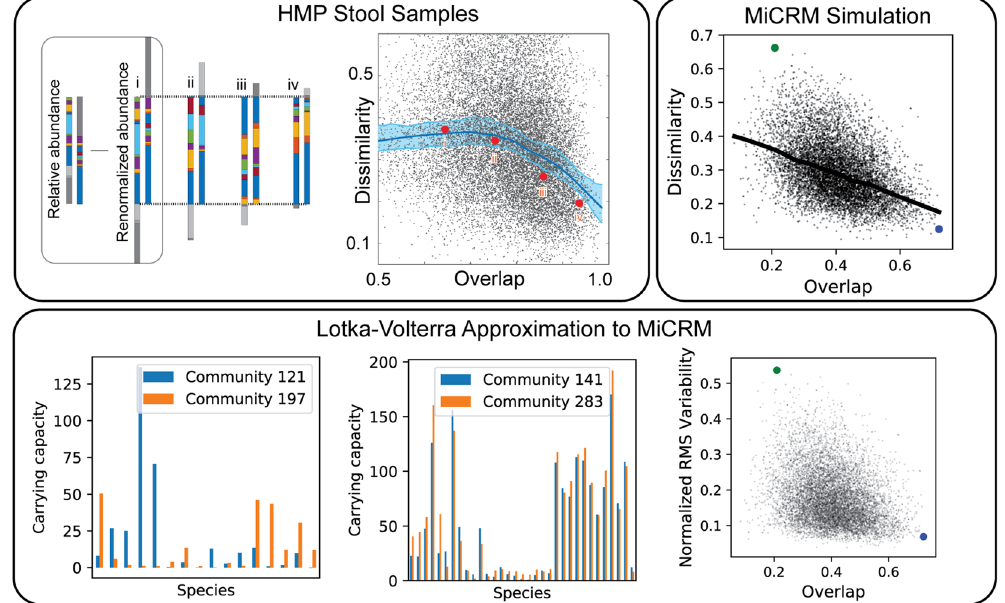
Figure 9. Host-specific dynamics are compatible with dissimilarity-overlap correlation. Top left: The composition of pairs of samples can be compared in two independent ways: “overlap” measures the fraction of each sample comprised by species common to both, and “dissimilarity” measures how different the relative abundance profiles are within this shared pool. The four pairs shown here have increasing overlap and decreasing dissimilarity from left to right, corresponding to the four points indicated in the scatter plot. Dissimilarity and overlap are plotted for 17,955 pairs of stool samples from the HMP, analyzed at the genus level. Solid line is a Lowess smoothing of the data, and red points correspond to the sample pairs illustrated in the first panel. Reproduced with permission from 33 . Top right: Dissimilarity and overlap for 10,000 pairs of simulated samples from the metabolically distinct simple environments of Fig. 6, with one resource supplied from class A and one from class B. Solid line is a Lowess smoothing of the data. Blue and green points correspond to two representative pairs of communities selected for further analysis in the bottom panel. Bottom: For each sample, the population dynamics near the steady state was approximated with a generalized Lotka-Volterra model. Effective carrying capacities and interaction coefficients computed from the mechanistic model parameters together with the population sizes and resource abundances, as described in the Methods. We have plotted the carrying capacity of each species for two representative pairs of communities with low (left) and high (center) overlap. These pairs are indicated in the scatter plots by blue and green points, respectively. We also show the normalized root-mean-square variability in carrying capacity for all 10,000 sample pairs